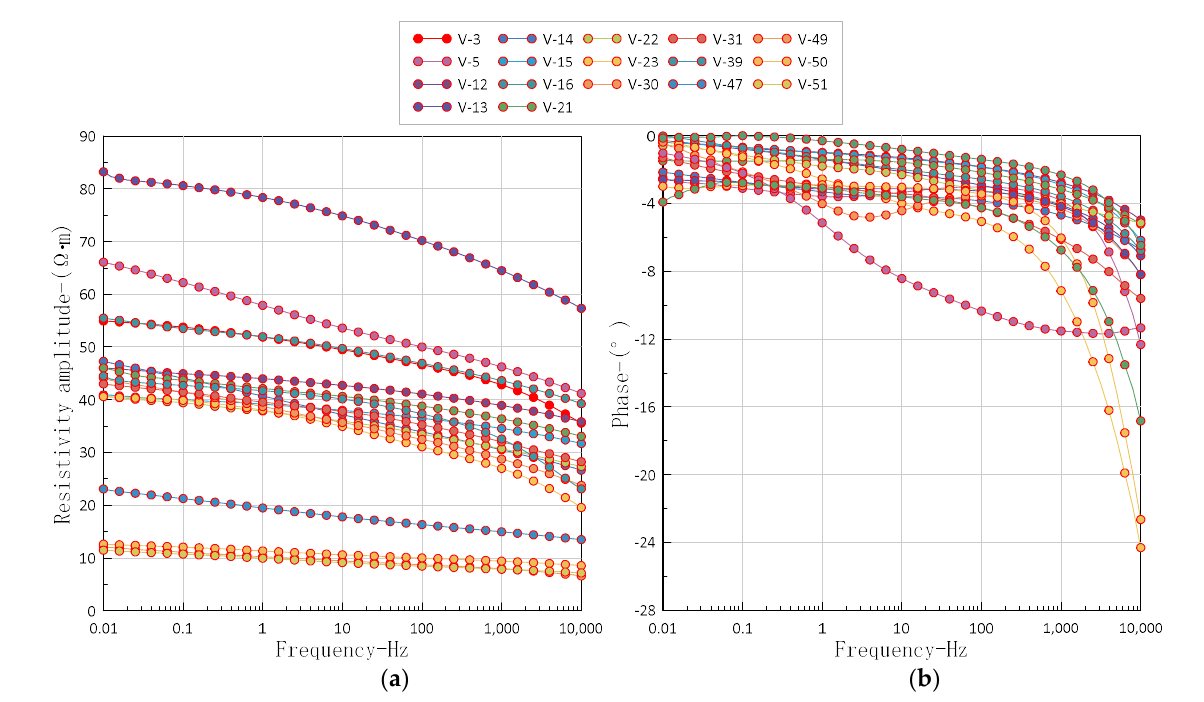
Figure 7. Amplitude and phase diagram of shale resistivity in H direction at high temperature and pressure. ( a ) resistivity amplitude; ( b ) phase.